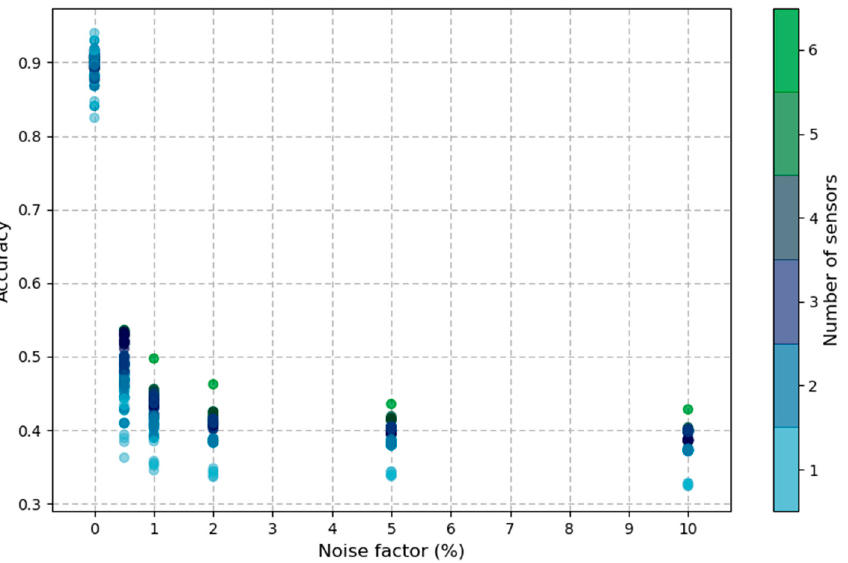
Figure 7. Tnet1 accurate leak location prediction as a function of the noise factor and the number of sensors.